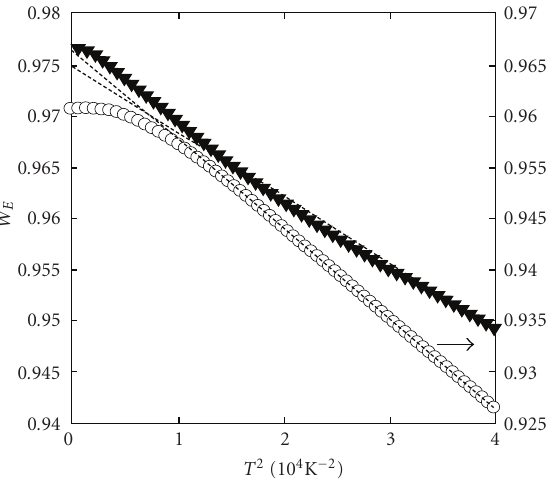
Figure 11: Spectral weight W ( Ω c , T ) in the normal state for Einstein phonons with Ω E = 200K (full triangles) and Ω E = 400K (open circles, left axis). Dashed lines show T 2 asymptotic. From [40].